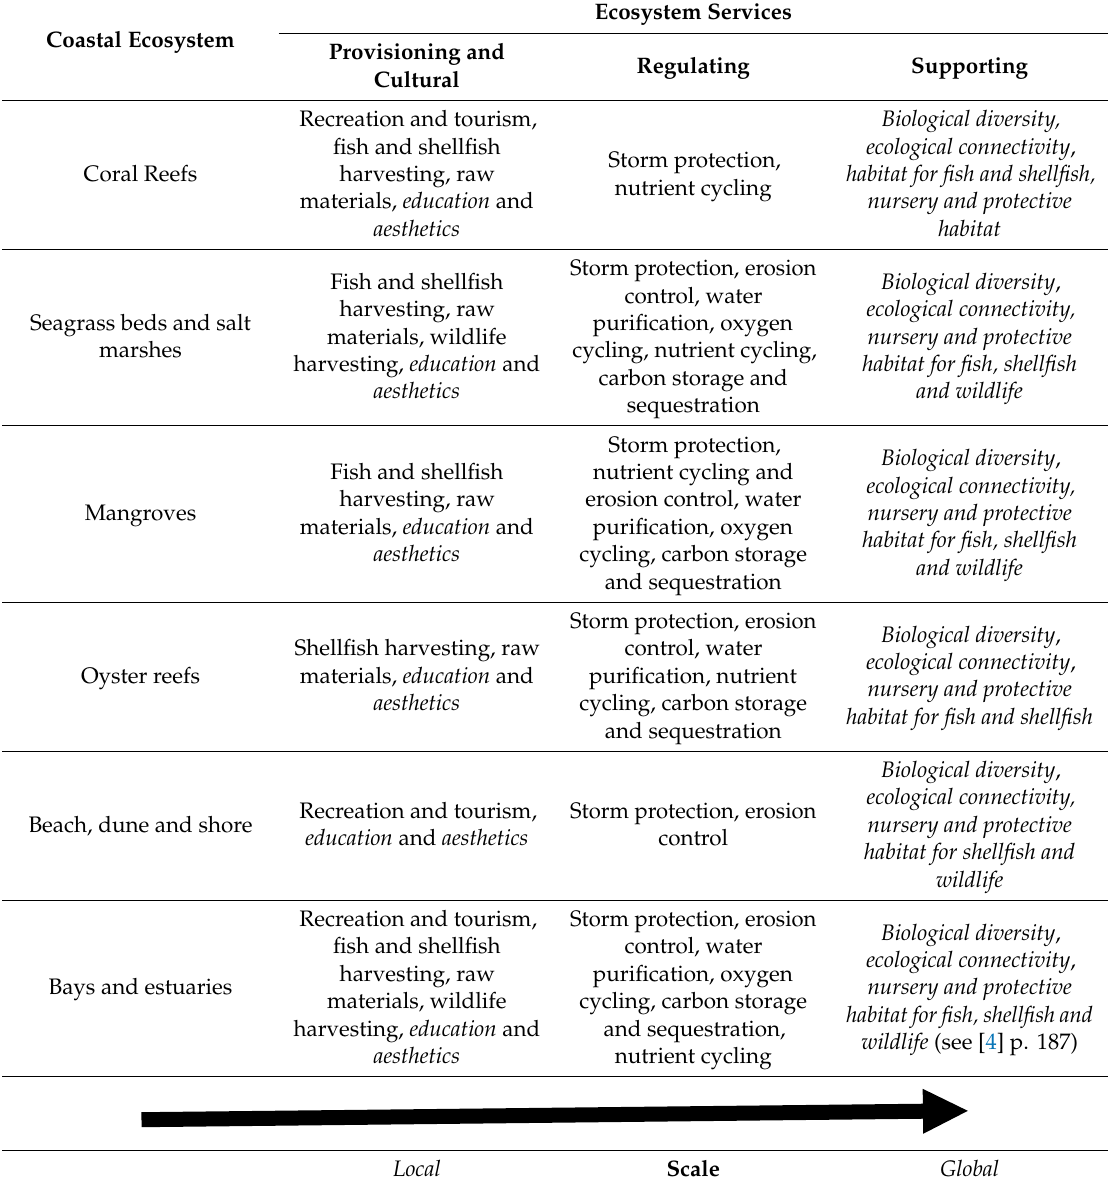
Table 1. Coastal ecosystems and types of economic values for ecosystem services. Direct and indirect use values in regular type, nonuse values in